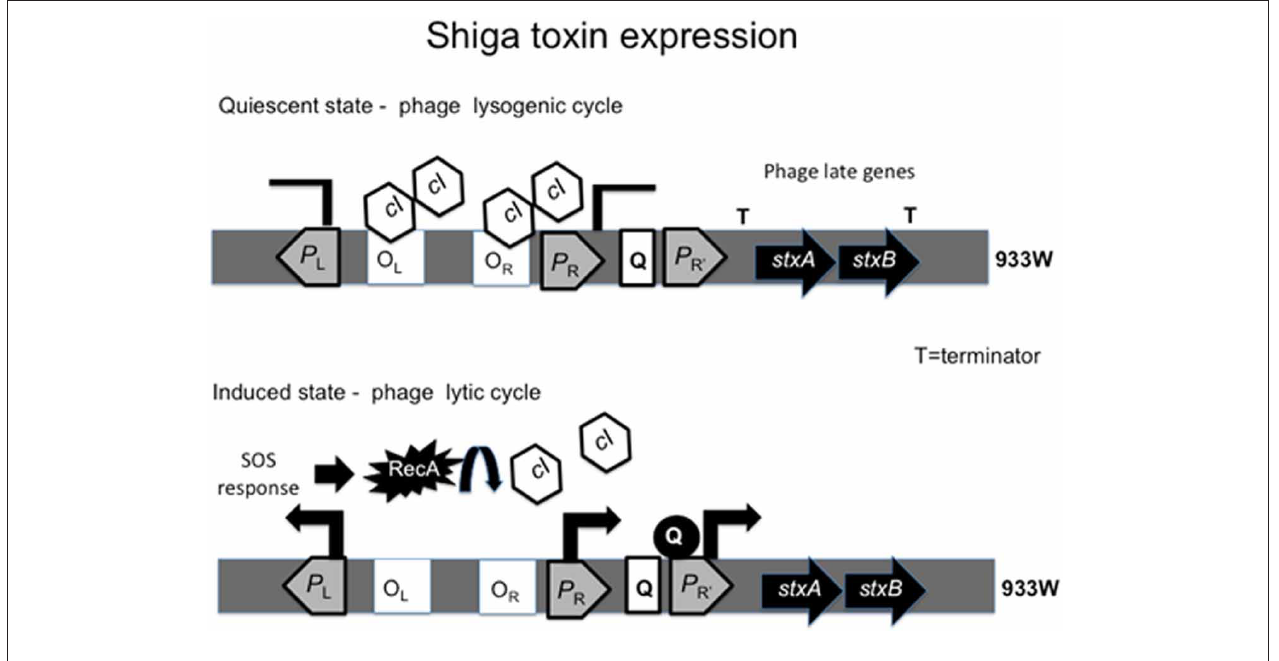
FIGURE 2 | Regulation of Shiga toxin expression by the phage cycle. The c I repressor bound to operator sites O L and O R inhibitis transcription from the promoters P L and P R . The presence of terminator downtream of P R (cid:2) inhibits transcription of stx AB and the phage remains